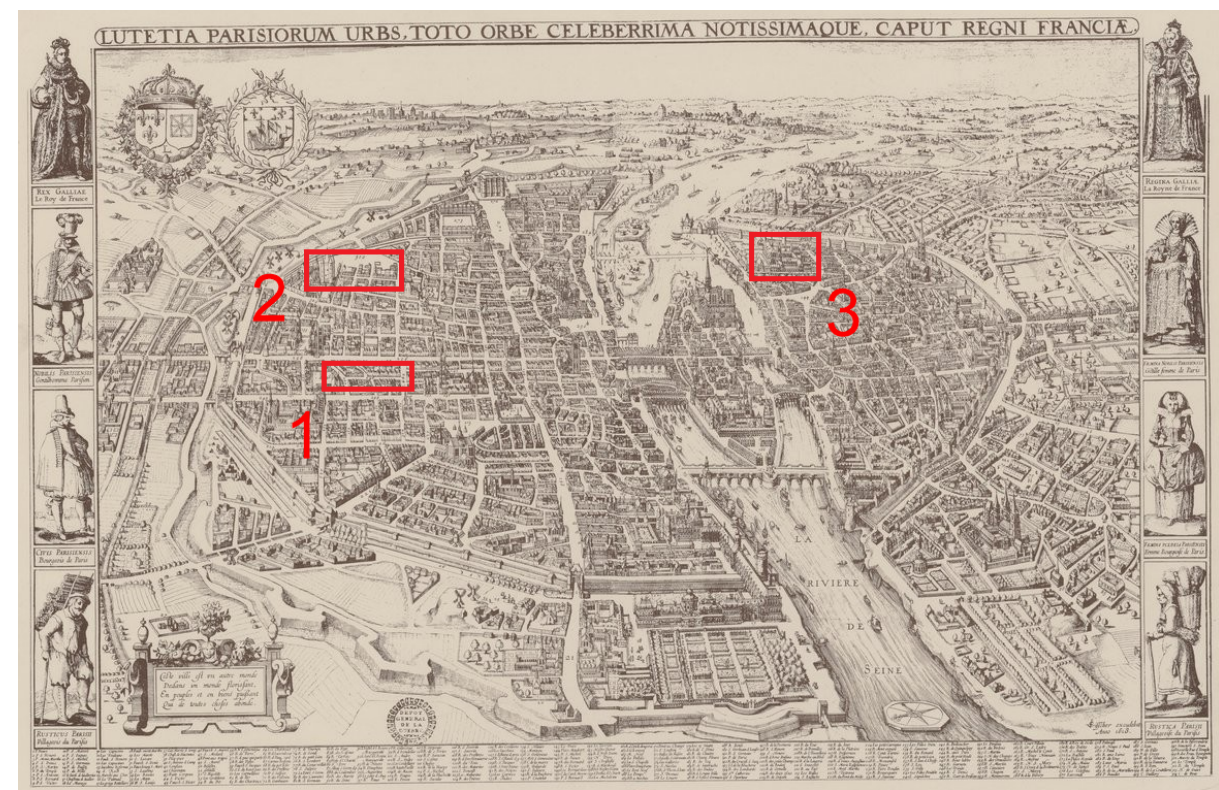
Figure 2. A map of Paris (Visscher, 1618). The marked locations show where Morin lived. Until October 1685, he lived on Quinquempoix Street (1), then until June 1688 in the Hotel Rohan-Soubisse (2), where the National Archives are located today, and until his death in 1715 he lived in the abbey Saint-Victor (3), which is located at the city border next to the Seine (source: https://gallica.bnf.fr/, last access: 4 January 2022/Bibliothèque nationale de